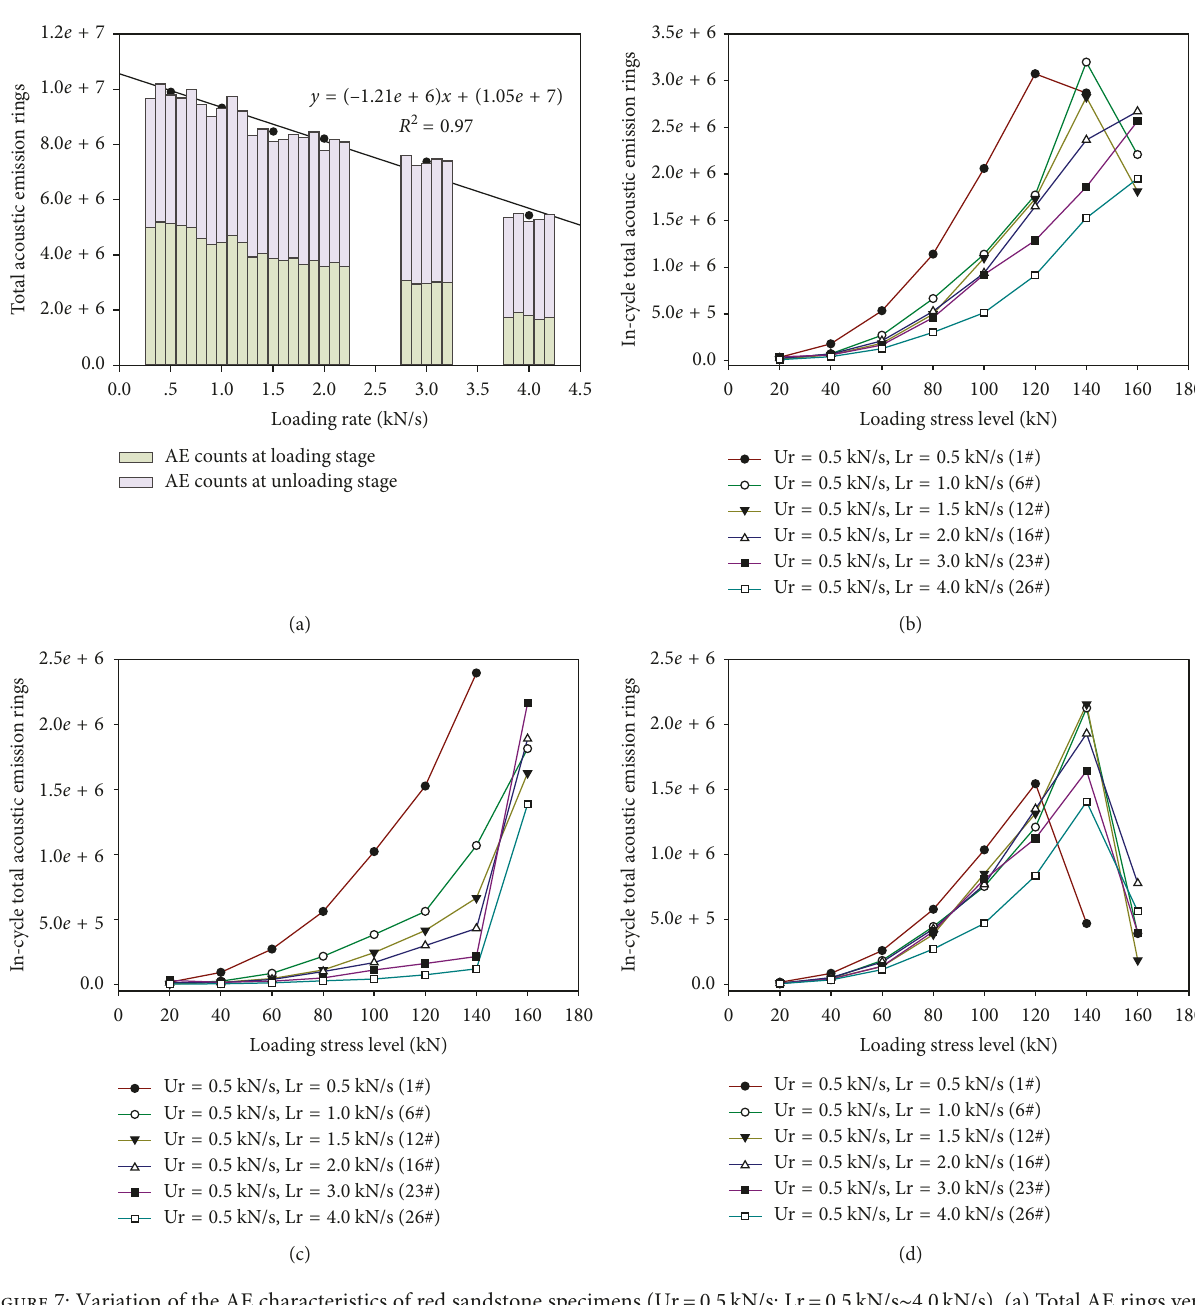
0.5kN/s; Lr 0.5kN/s ∼ 4.0kN/s). (a) Total AE rings versus (cid:30) (cid:30)